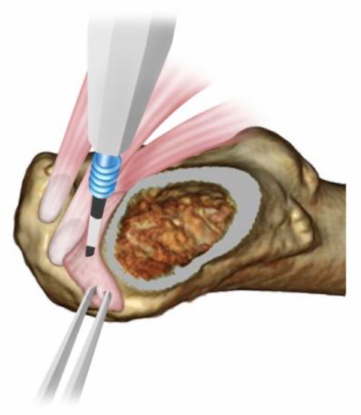
Figure 4. Resection of ischiofemoral ligament remnant. The conjoint tendon and Oe can be seen in direct view after resection of the ischiofemoral ligament remnant.